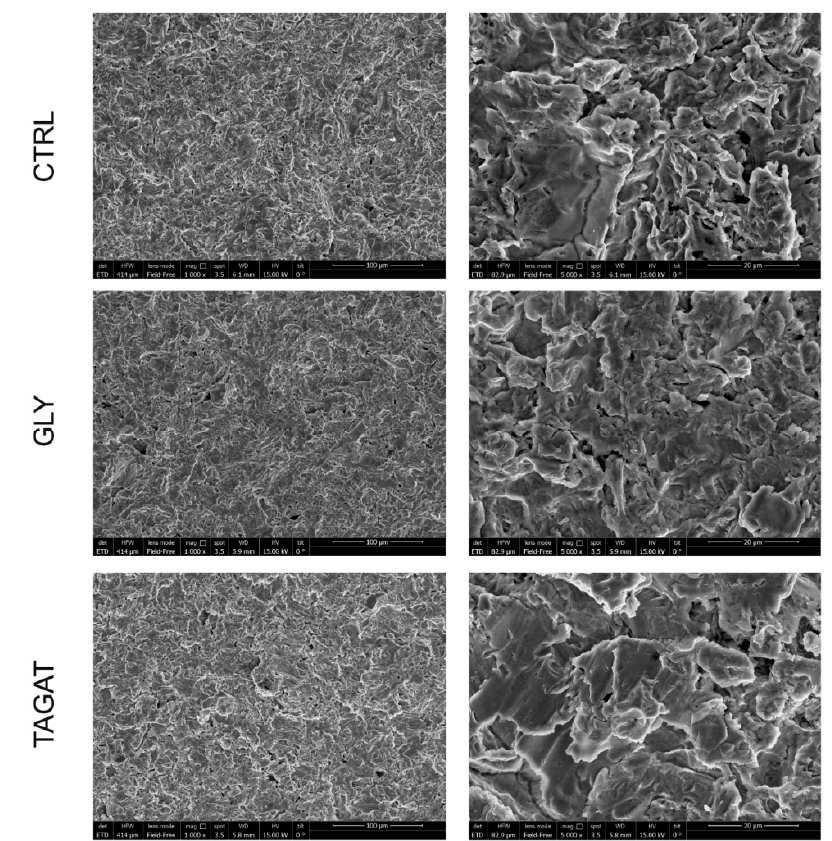
Figure 2. Titanium surface topography. Scanning electron microscopy (SEM) analysis at different magnifications was carried out on titanium surfaces from the three experimental groups (CTRL, GLY, TAGAT) in order to evaluate the surface topography. Scale bars: 100 µm (left) and 20 µm (magnifications on the right).